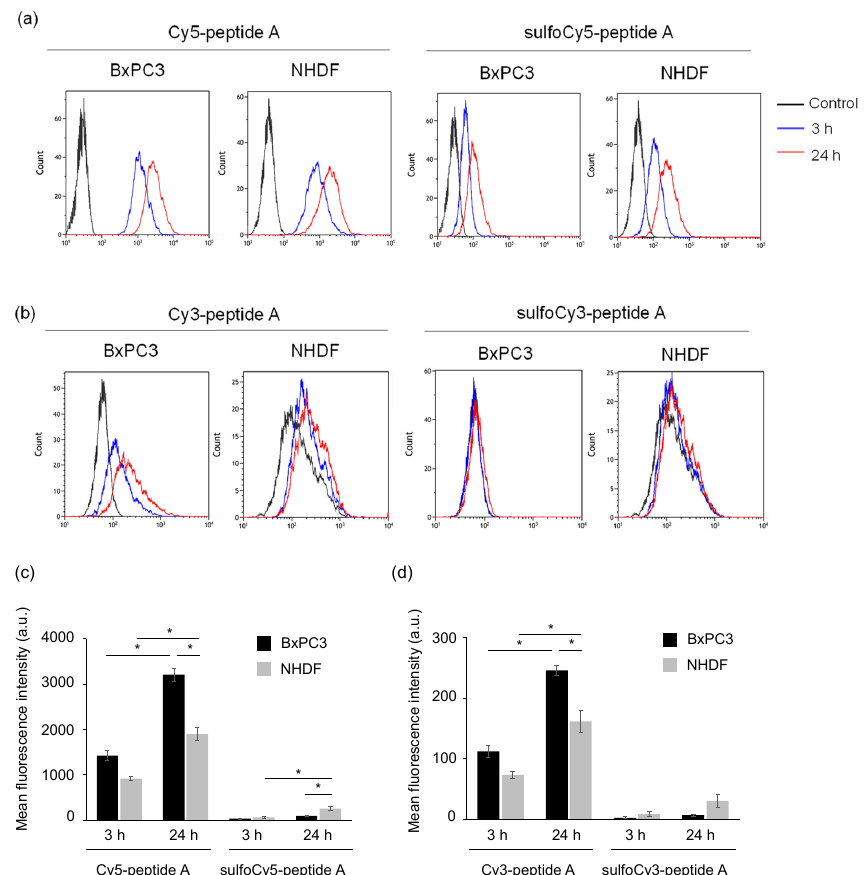
Figure 4. Flow cytometry of BxPC3 and NHDF cells treated with dye-peptide A. The histograms of ( a ) Cy5/sulfoCy5-peptide A and ( b ) Cy3/sulfoCy3-peptide A. The analysis of ( c ) Cy5/sulfoCy5- peptide A and ( d ) Cy3/sulfoCy3-peptide A. Cells were incubated with 0.1 μ M dye-peptide A at 37 °C for 3 or 24 h before flow cytometry. The data represent the mean ±SEM ( n = 3). The statistical significance was assessed by Tukey-Kramer test (* p < 0.01).